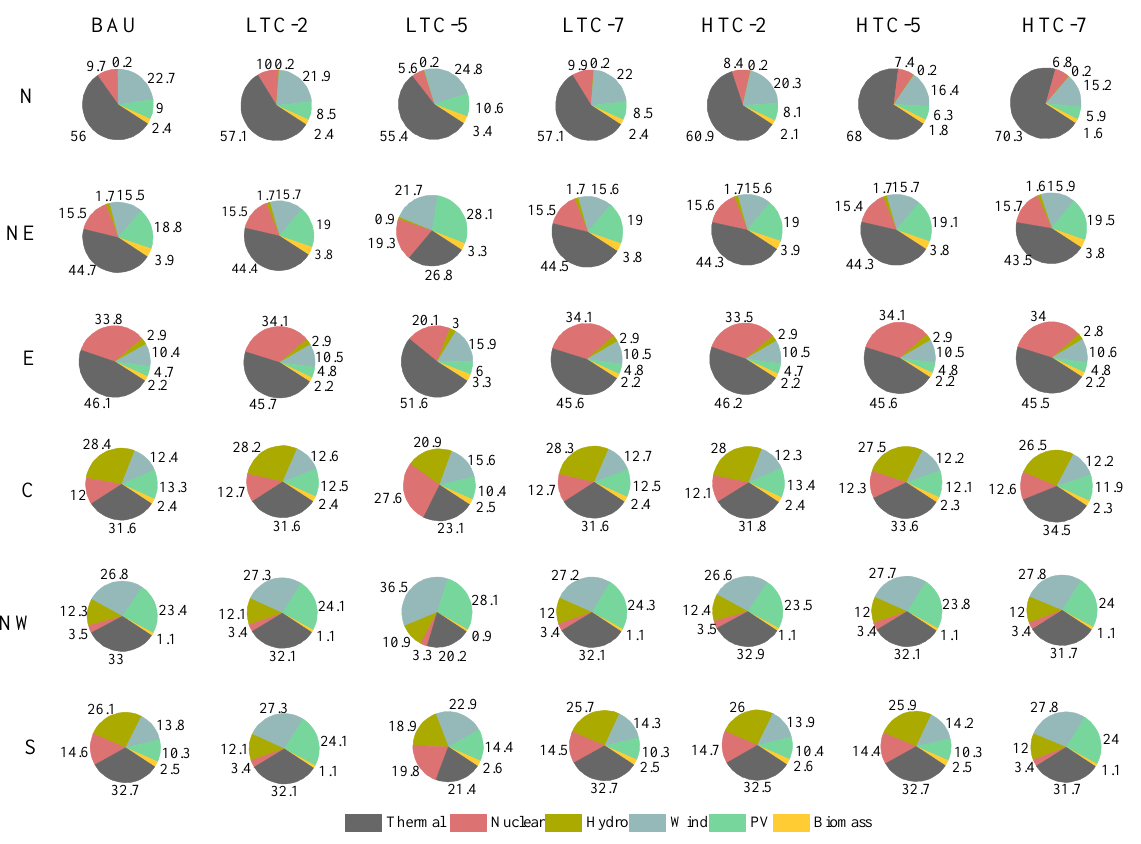
Figure 9. Optimal Power Generation Structure in Different Transmission Capacity Scenarios (2040) (unit: %).